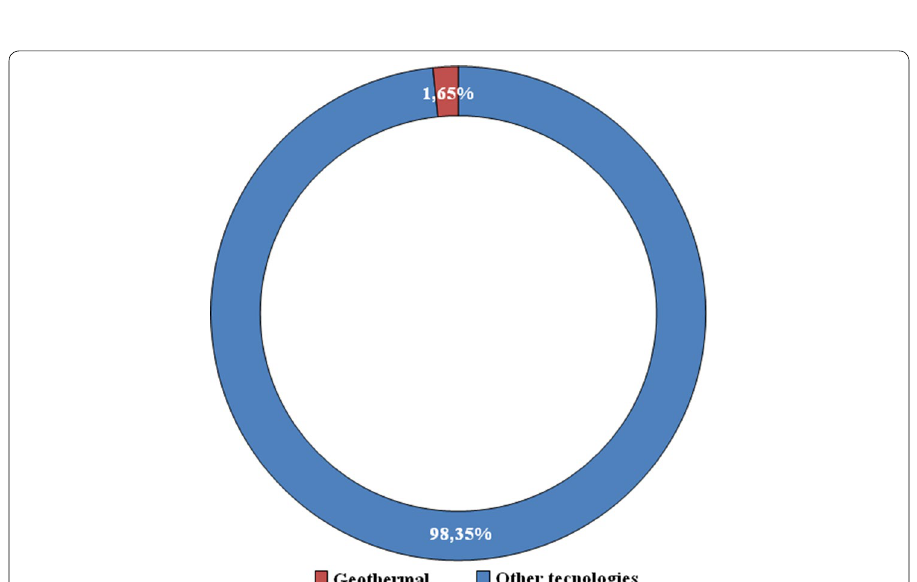
Fig. 7 Share of geothermal electricity in total electricity generation in Colombia by